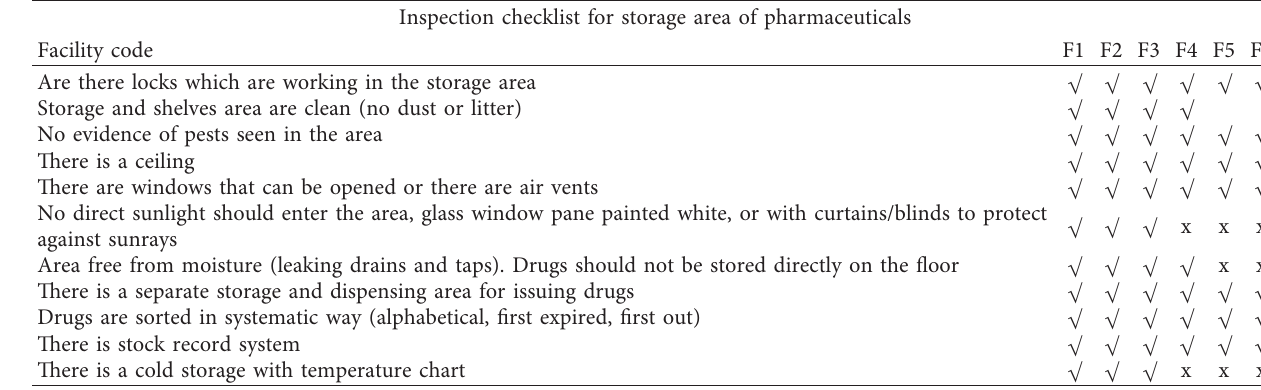
Table 2: Checklist for evaluation of storage area of governmental health facilities from which the tablet batches were sampled. Inspection checklist for storage area of pharmaceuticals Facility code